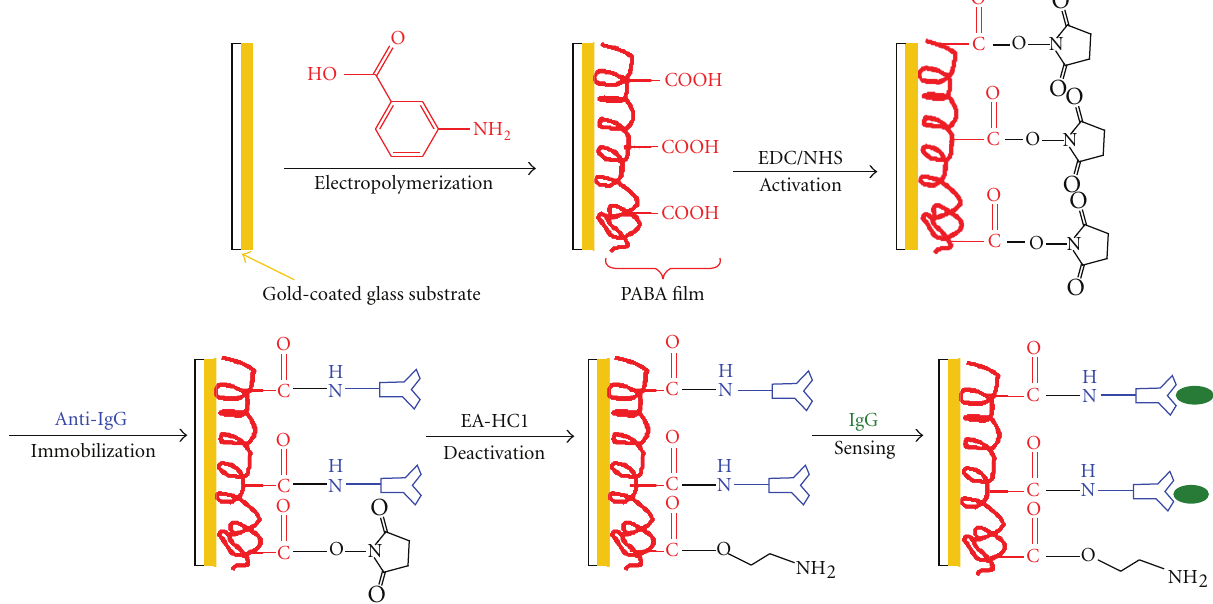
Figure 2: Schematic diagram of the construction of PABA-based immunosensor and sensing of human IgG [30].